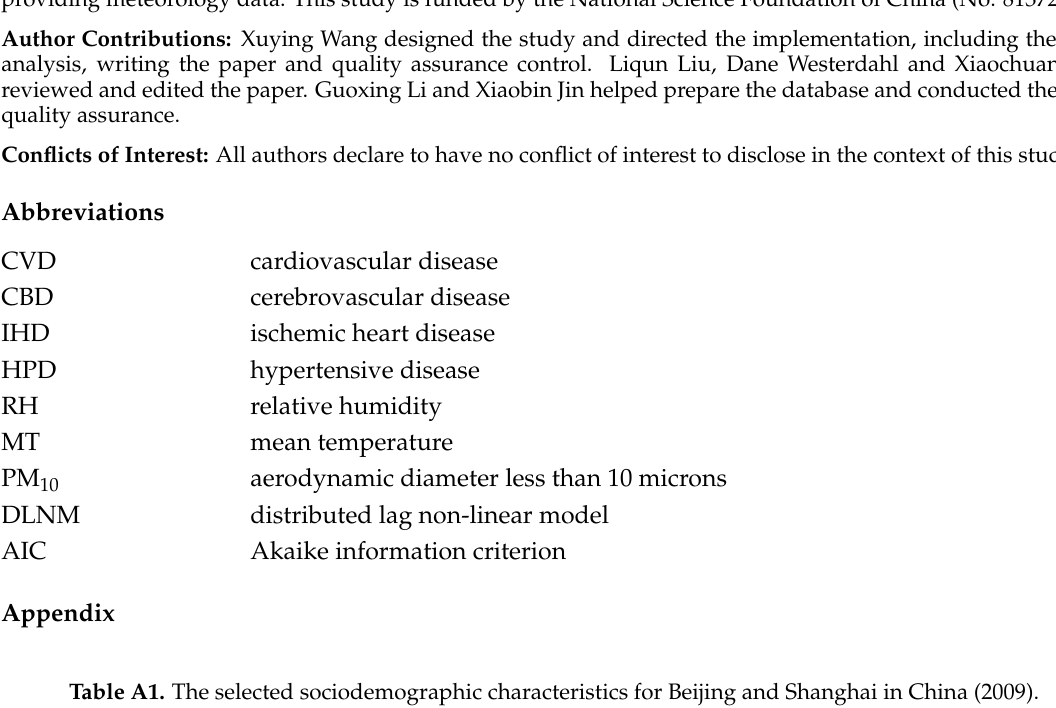
Table A1. The selected sociodemographic characteristics for Beijing and Shanghai in China